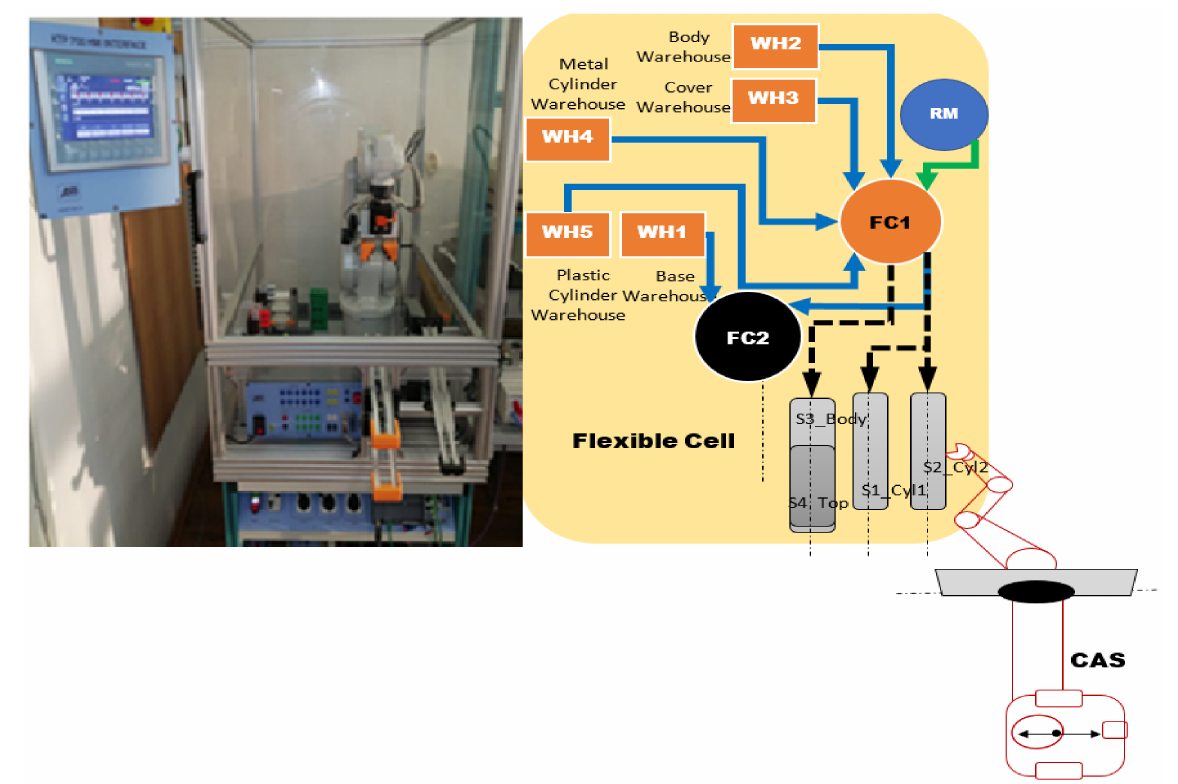
Figure 3. Flexible Cell Station with 6-DOF ABB